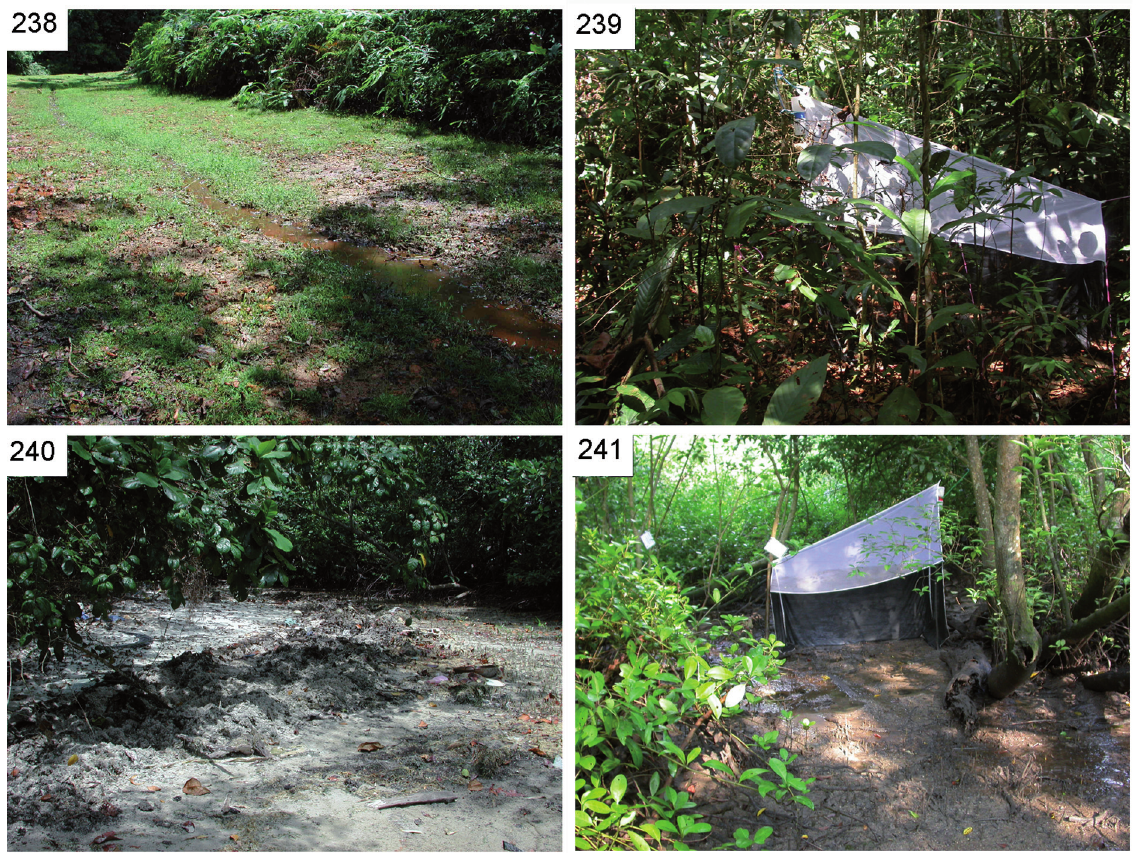
Figs 238-241. Photographs of Tachydromiinae habitats in Singapore. 238 . Nee Soon (Upper Peirce Park reservoir), marsh land in swamp forest. The black Elaphropeza species E. neesoonensis Shamshev & Grootaert, 2007 and E. meieri Shamshev & Grootaert, 2007 occur here on the short grasses. 239 . Nee Soon (Upper Peirce Park reservoir), Malaise trap in swamp forest. Mainly yellow-bodied Elaphropeza species do occur in this type of forest. 240 . Pulau Ubin, Chek Jawa – partly shaded sand patch in the mangrove. Wrack on the supralittoral part of the beach is mainly composed of decaying green algae and is being disturbed by wild boar probably digging for ghost crabs. This is the only site where three Drapetis species ( D. bakau sp. nov., D. laut sp. nov. and D. pantai sp. nov.) and four species of Chersodromia ( C. glandula sp. nov., C. malaysiana sp. nov., C. nigripennis Shamshev & Grootaert, 2005 and C. singaporensis Shamshev & Grootaert, 2005) have been found. In addition it is type locality for Stilpon nigripennis sp. nov., Empis producta Daugeron & Grootaert, 2005 and E. vitisalutatoris Daugeron & Grootaert, 2005 are swarming above the wrack and in the undergrowth. 241 . Kranji Nature trail (KNT02) on the border of Sungei Buloh Wetland Reserve. About 120 species of dance (Empididae, Hybotidae) and longlegged flies (Dolichopodidae) have now been recorded there and the site is type locality of 34